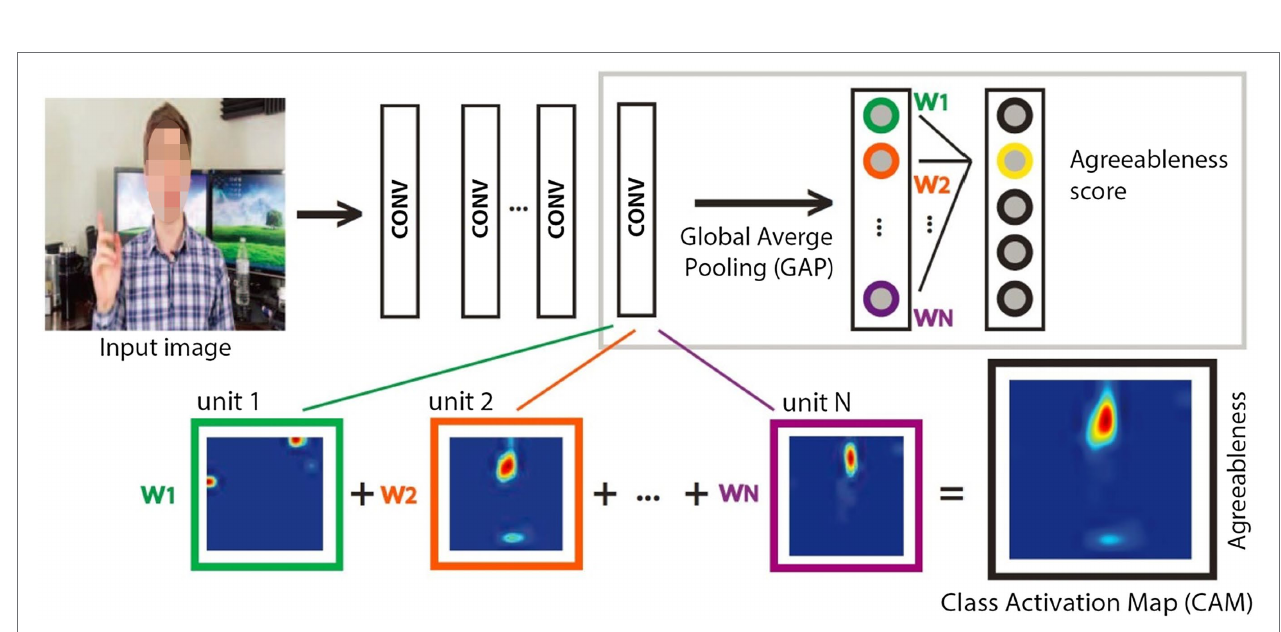
FIGURE 4 | The used class activation maps (CAM) to interpret the CNN models in learning facial features (Ventura et al.,